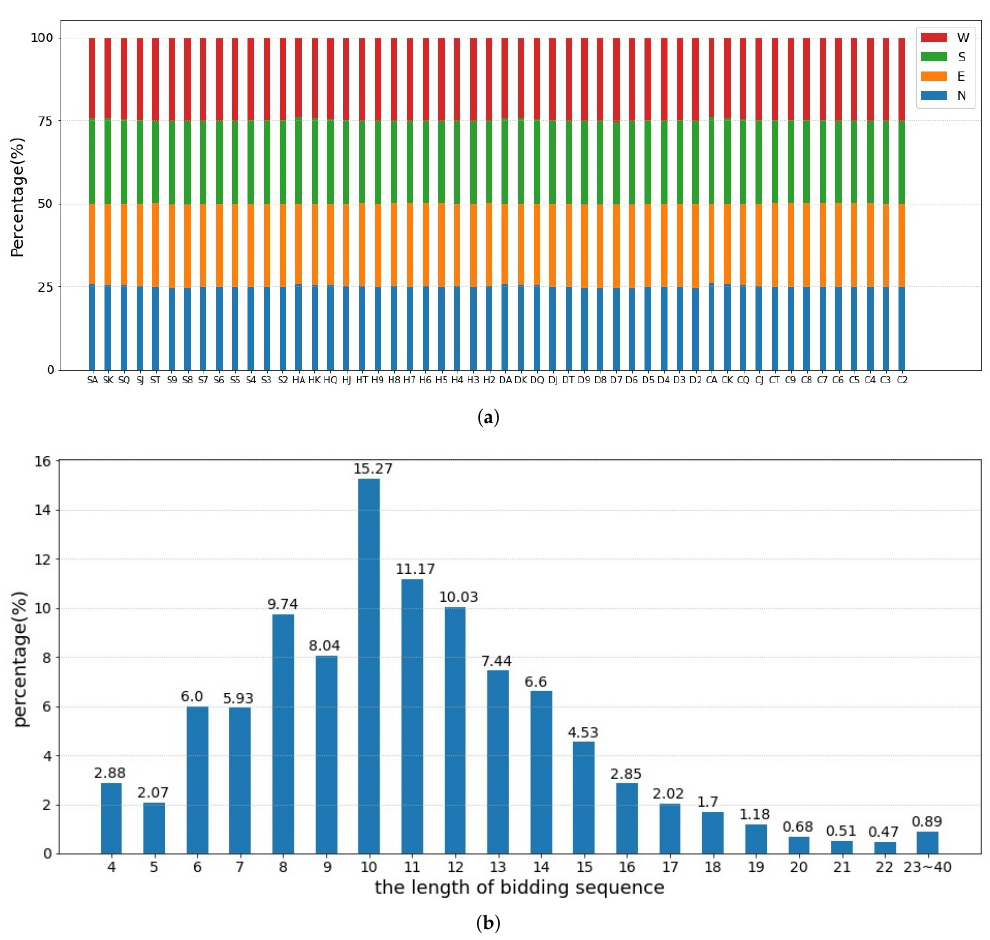
Figure 7. Dataset Evaluation. ( a ) The percentage of each card among four players. ( b ) The distribution of lengths of bidding